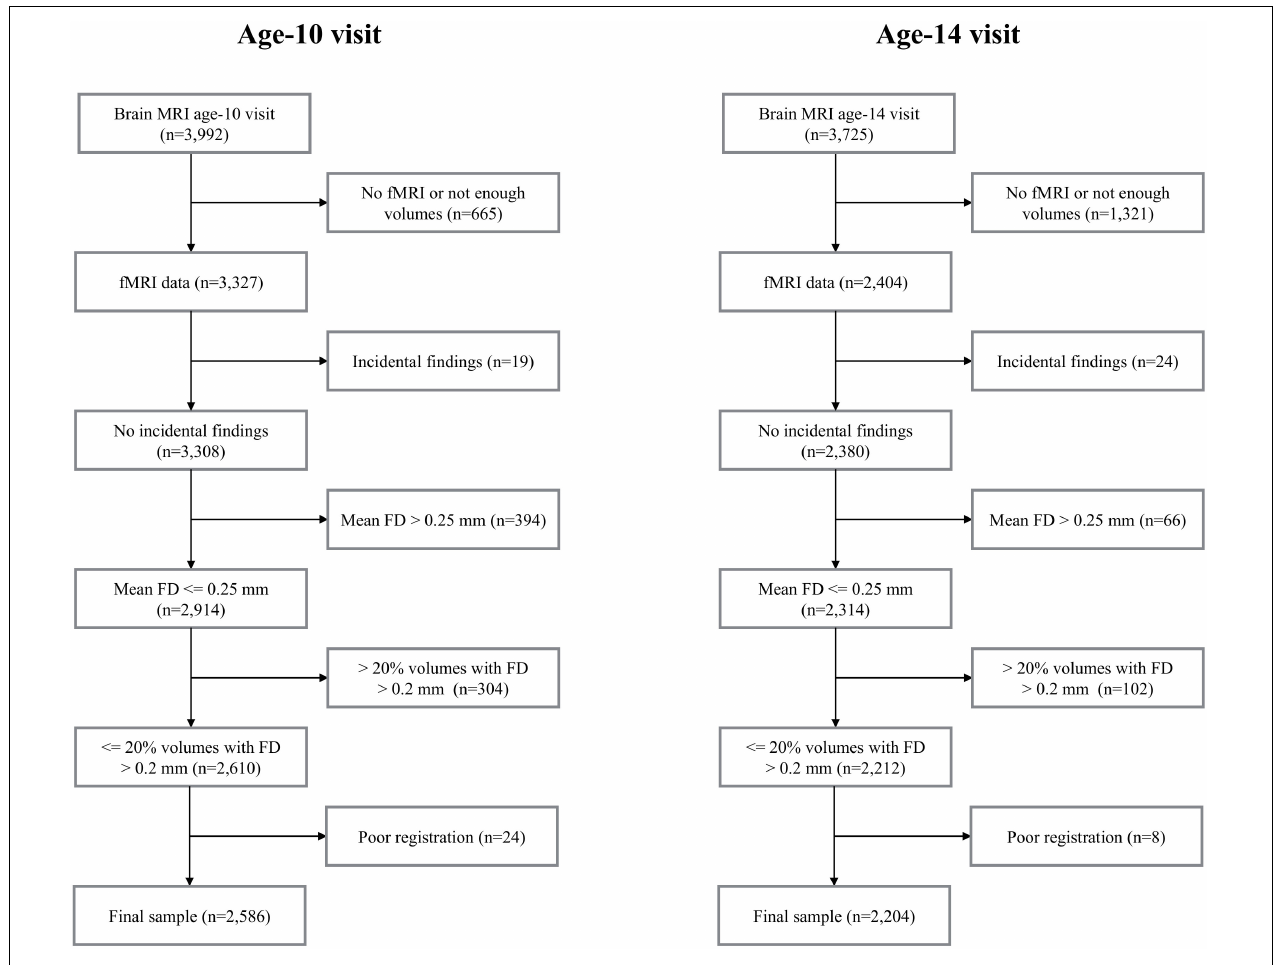
FIGURE 1 | Flowcharts. MRI, magnetic resonance imaging; FD, framewise